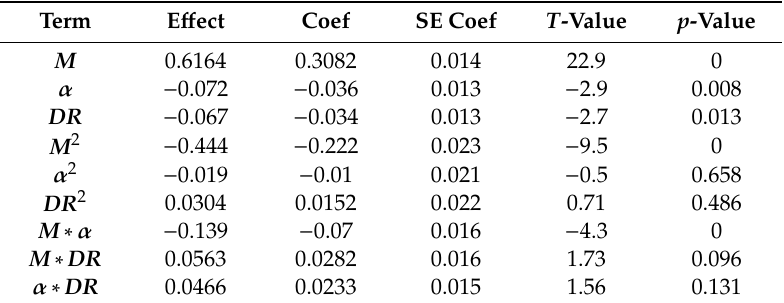
Table 4. RSM model summary.